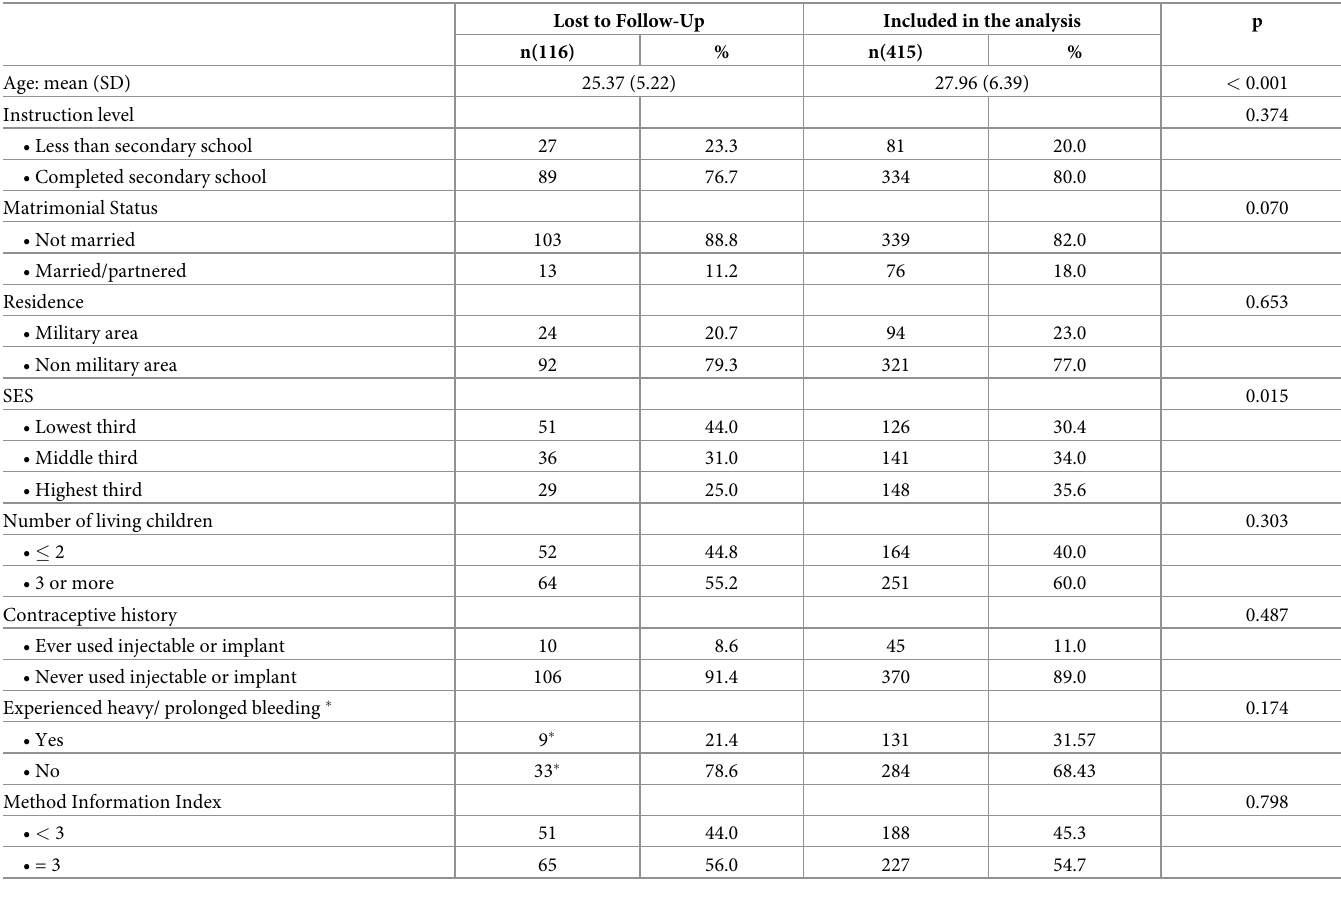
Table 1. Sociodemographic characteristics and past contraceptive use of women LTFU and women included in the